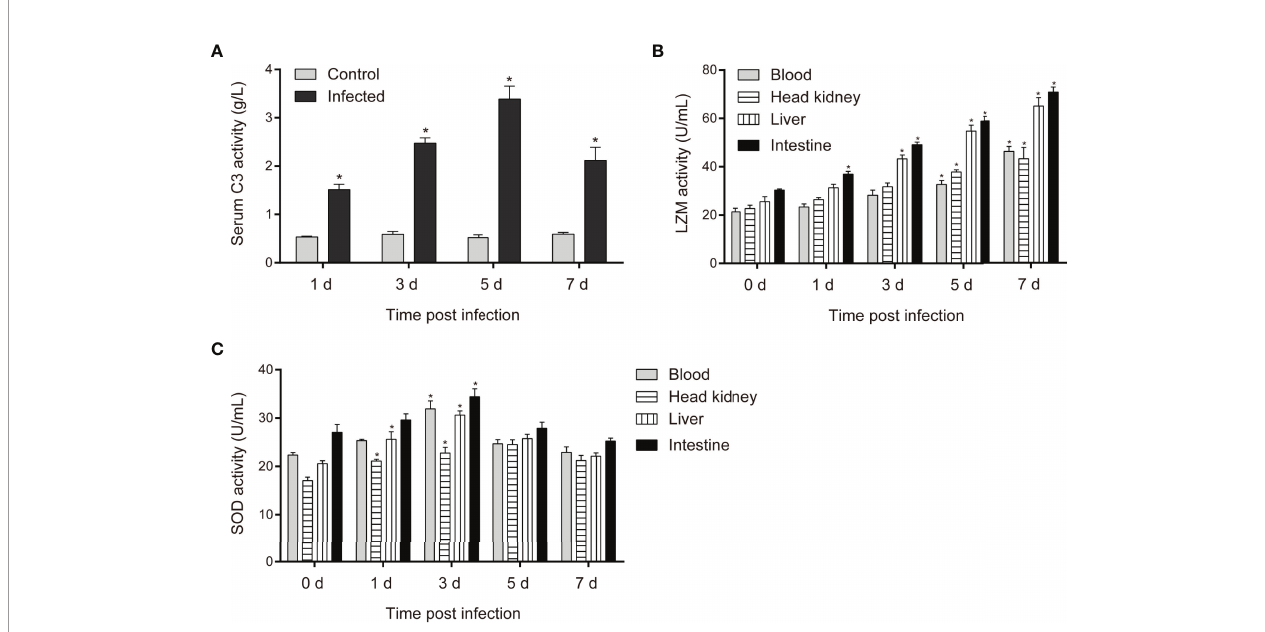
FIGURE 5 | (A) Changes in complement C3 levels in the serum of C carpio with time after P. shigelloides challenge. (B) Changes in LZM activity in tissues of C carpio with time after P. shigelloides challenge. (C) Changes in SOD activity in tissues of C carpio with time after P. shigelloides challenge. "*" means P <